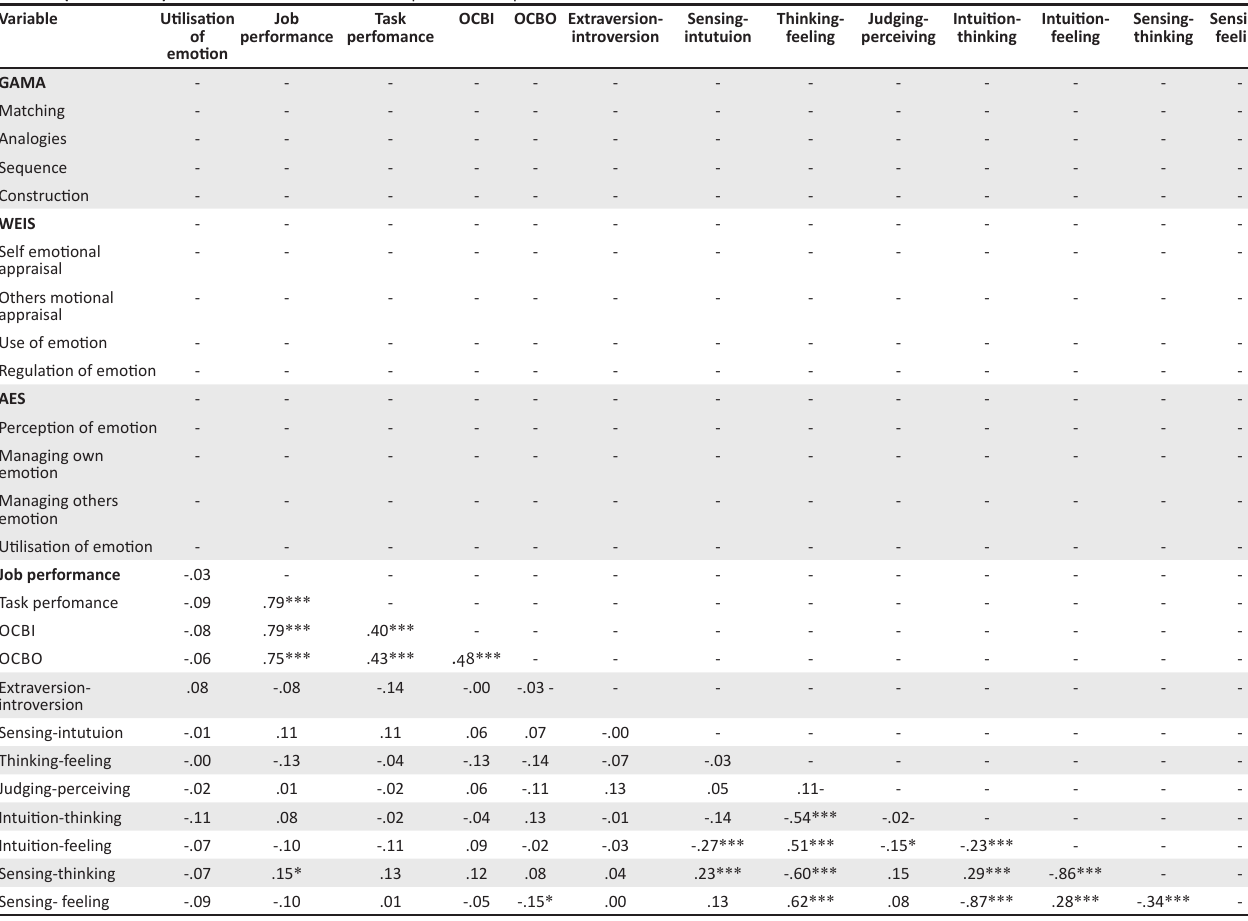
TABLE 4 (Continues...): Bivariate correlations of the dependent and predictor variables.